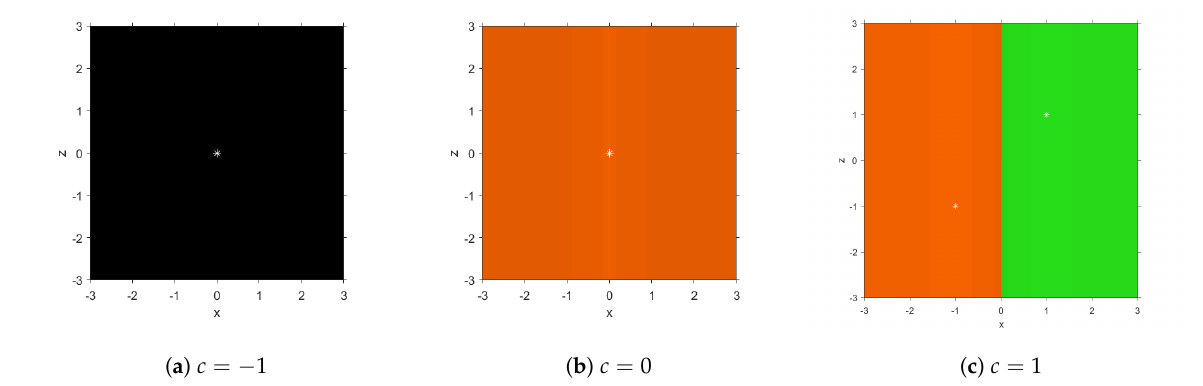
Figure 1. Dynamical planes of PM 6 method on p ( x ) , for different values of c .